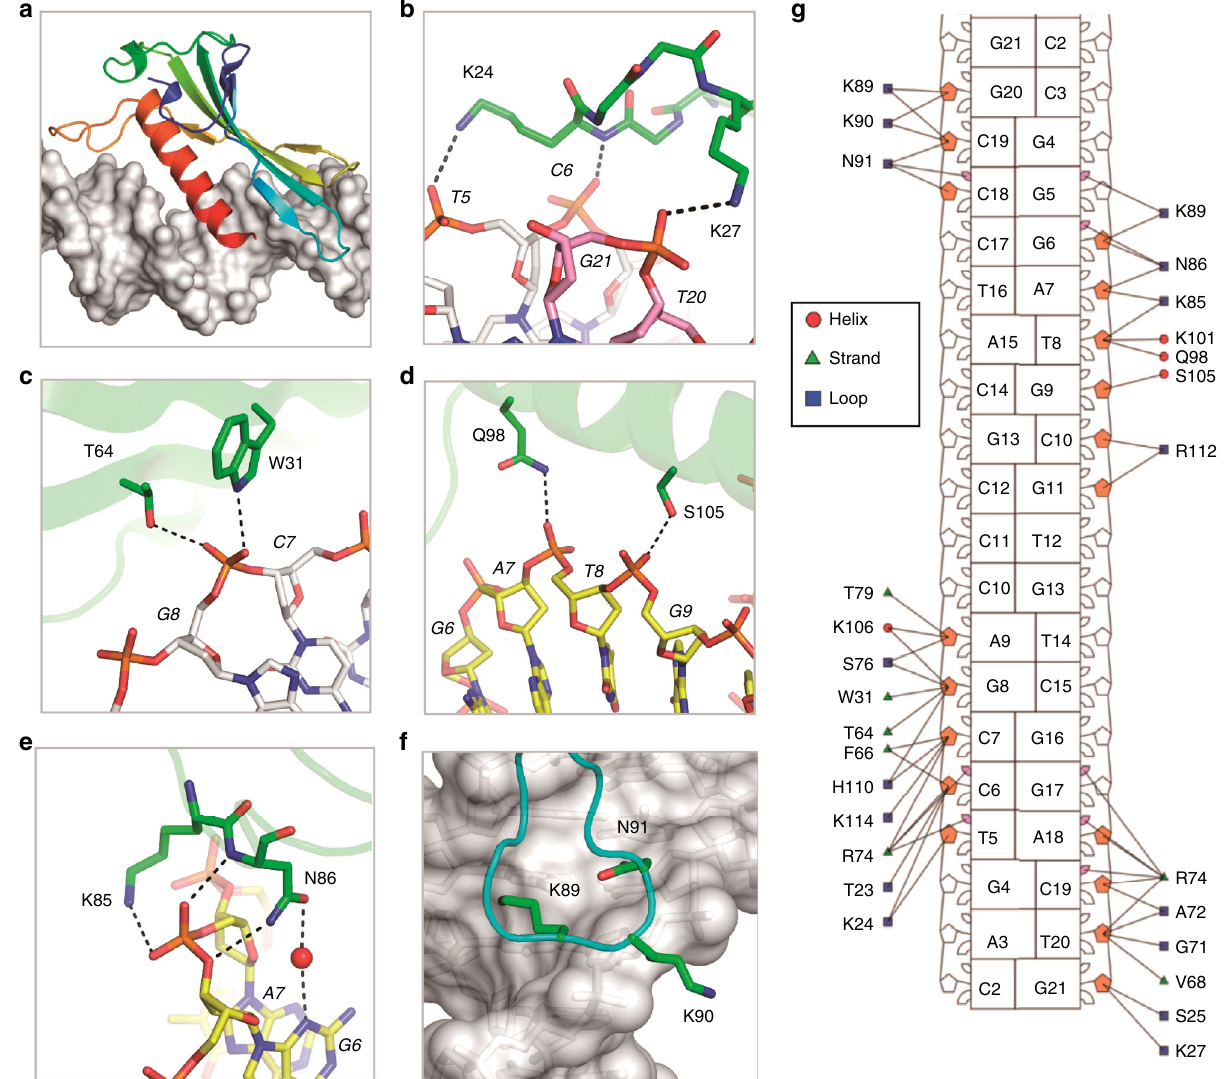
Fig. 3 The interaction between DNA and Asfv LIG NTD. a Cartoon-and-surface view showing the relative orientation between Asfv LIG NTD and DNA. b – f Detailed interactions between Asfv LIG NTD and DNA residues. Asfv LIG NTD residues are shown as sticks in atomic colors (C, green; N, blue; O, red); the DNAs are also shown as sticks, the C-atoms of the template strand, upstream and downstream of the broken strand are colored in white, yellow, and pink, respectively. g Nucleotide-residue contact map showing individual nucleotide-residues interactions for the preferred binding site. Small and large markers on each nucleotide represent the major and minor groove contacts, respectively. Filled-in pink markers highlight which nucleotides are contacted by at least one residue in the minor